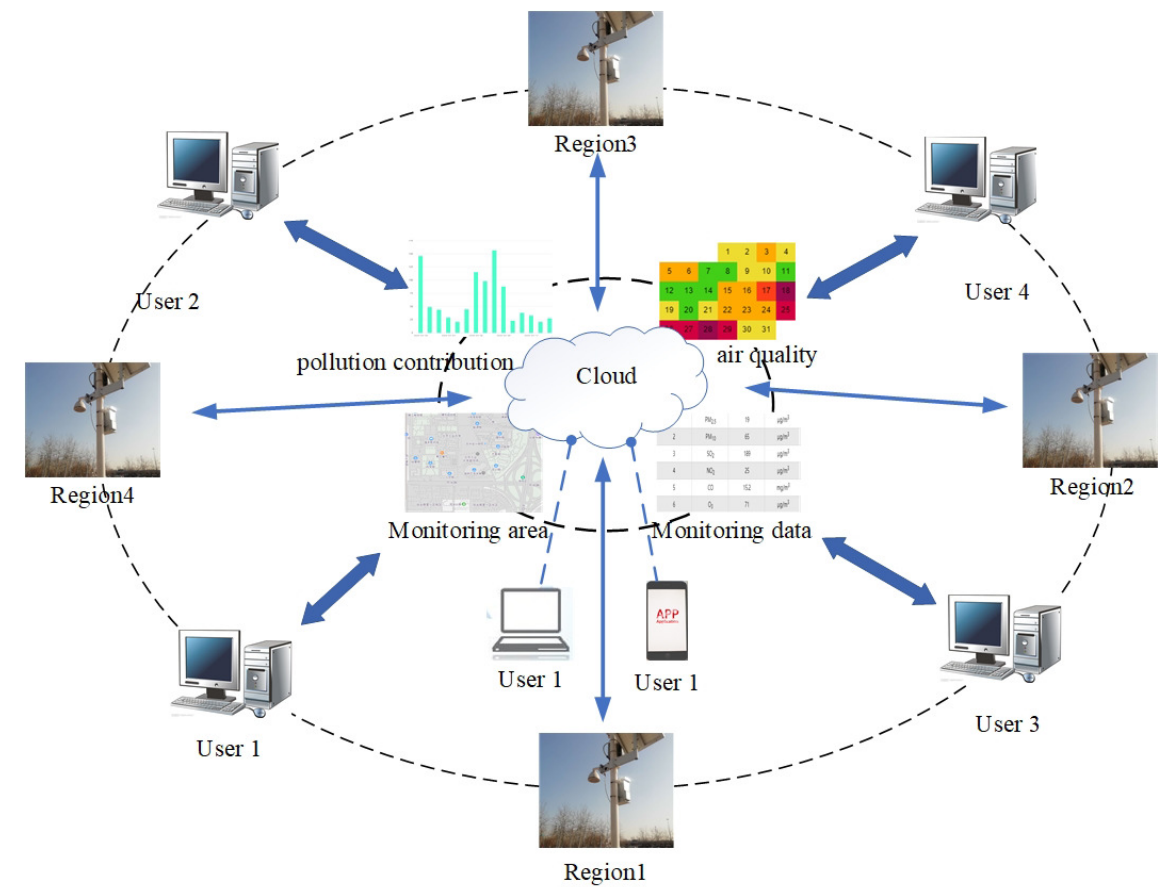
Figure 1. Schematic of atmospheric data monitoring platform.